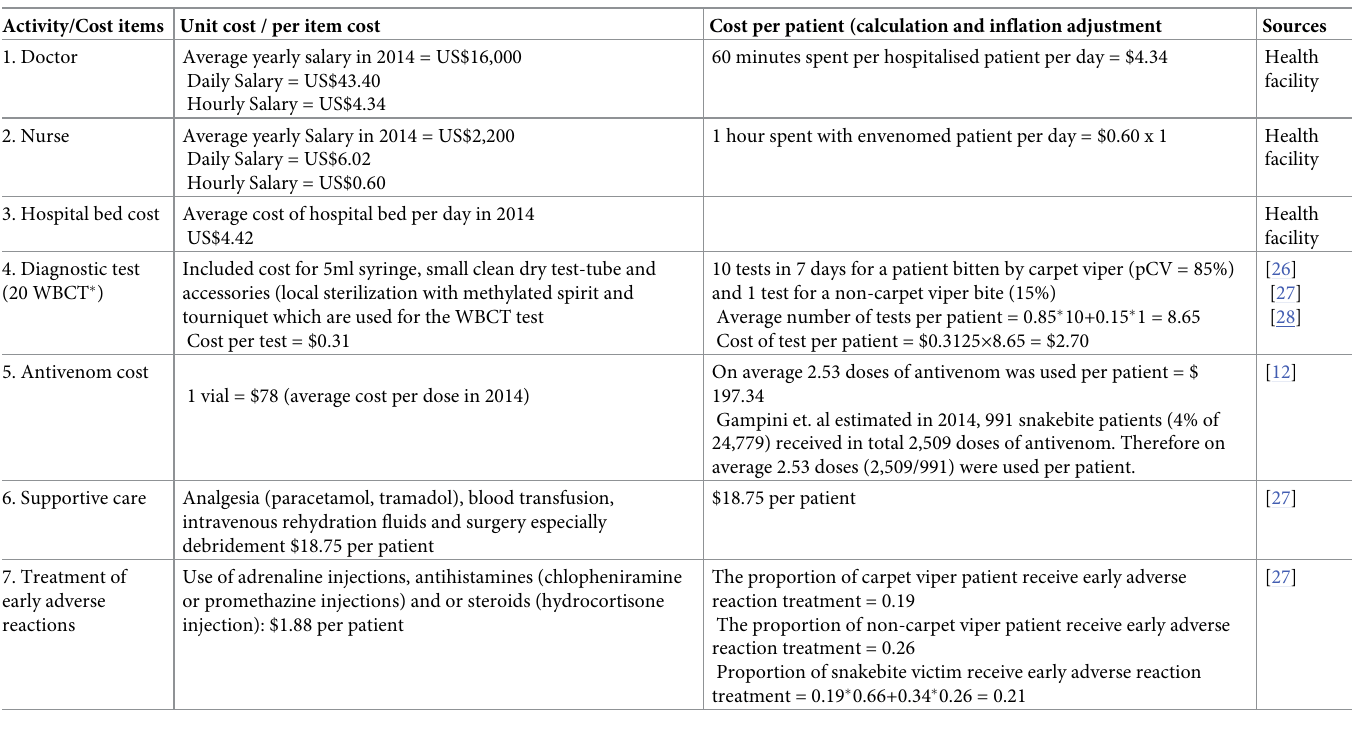
Table 1. Economic burden estimation of hospital services to snakebite patients.